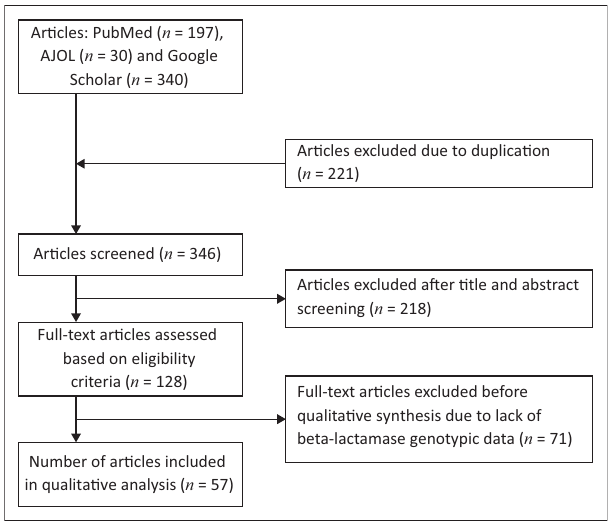
FIGURE 1: Flow diagram summarising the process of literature search and selection.